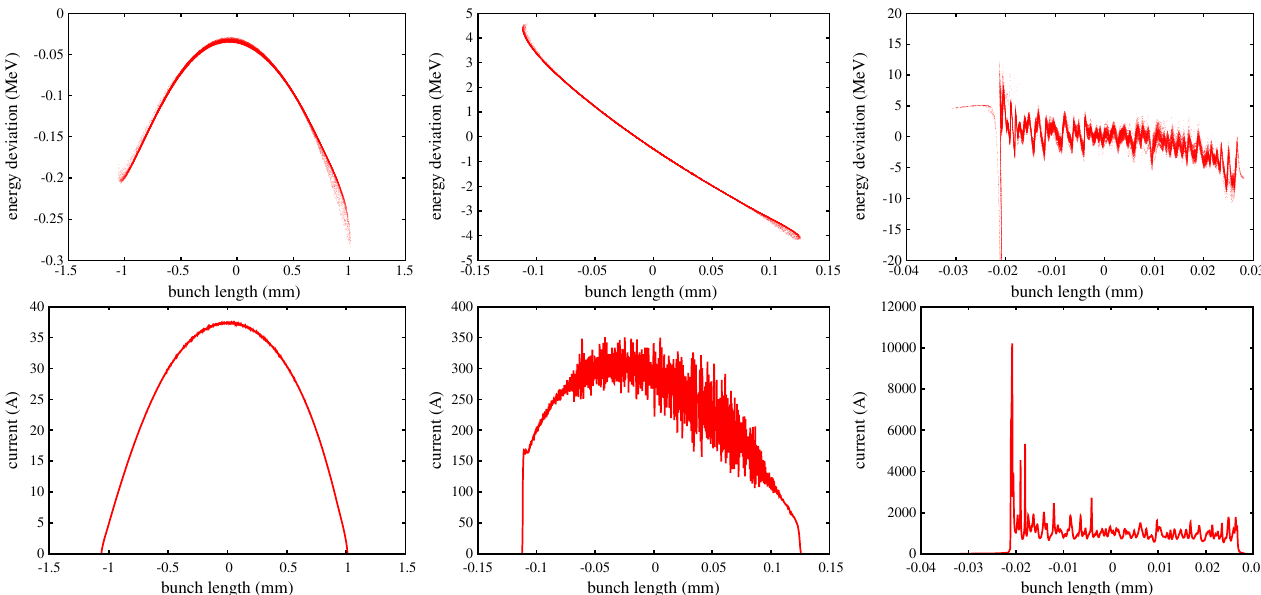
FIG. 4. Simulated electron beam longitudinal phase space (top) and current profile (bottom) at injector 135 MeV (left), after bunch compressor BC1 (middle), and after DL2 (right). Bunch charge is 180 pC; the laser heater was off.